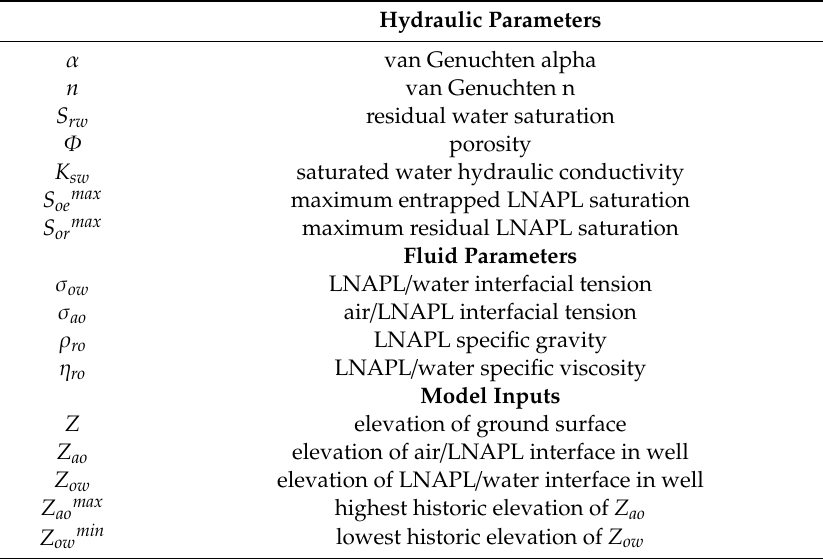
Table 1. Model Inputs and